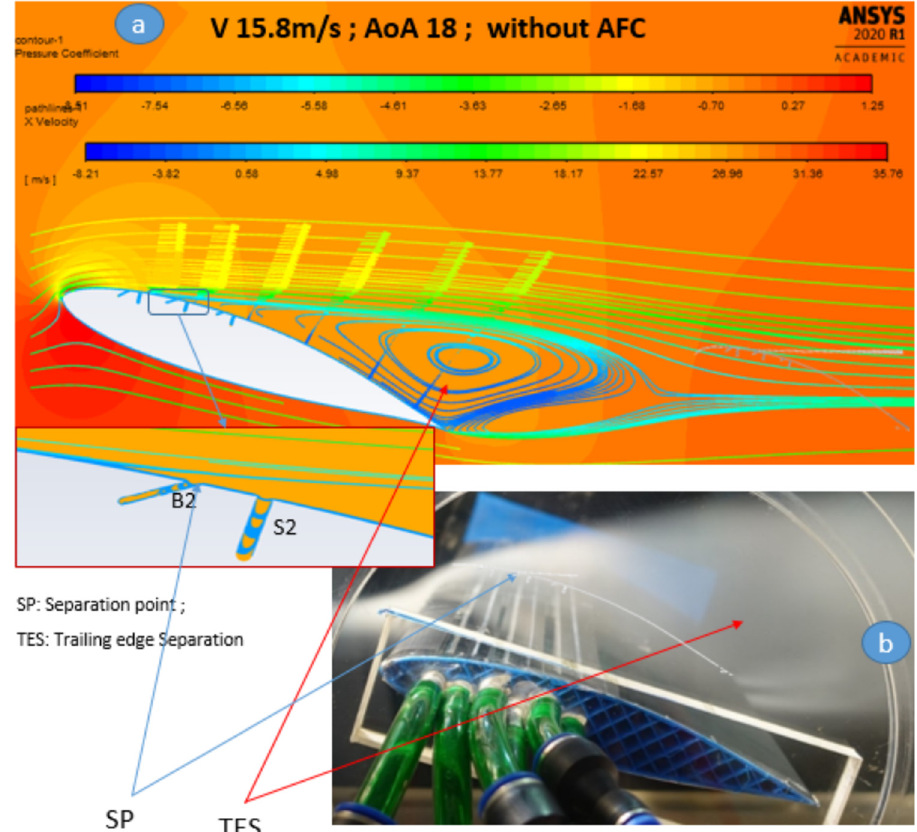
Fig. 6. Results of Flow visualisation around the aerofoil for the baseline case (no AFC).